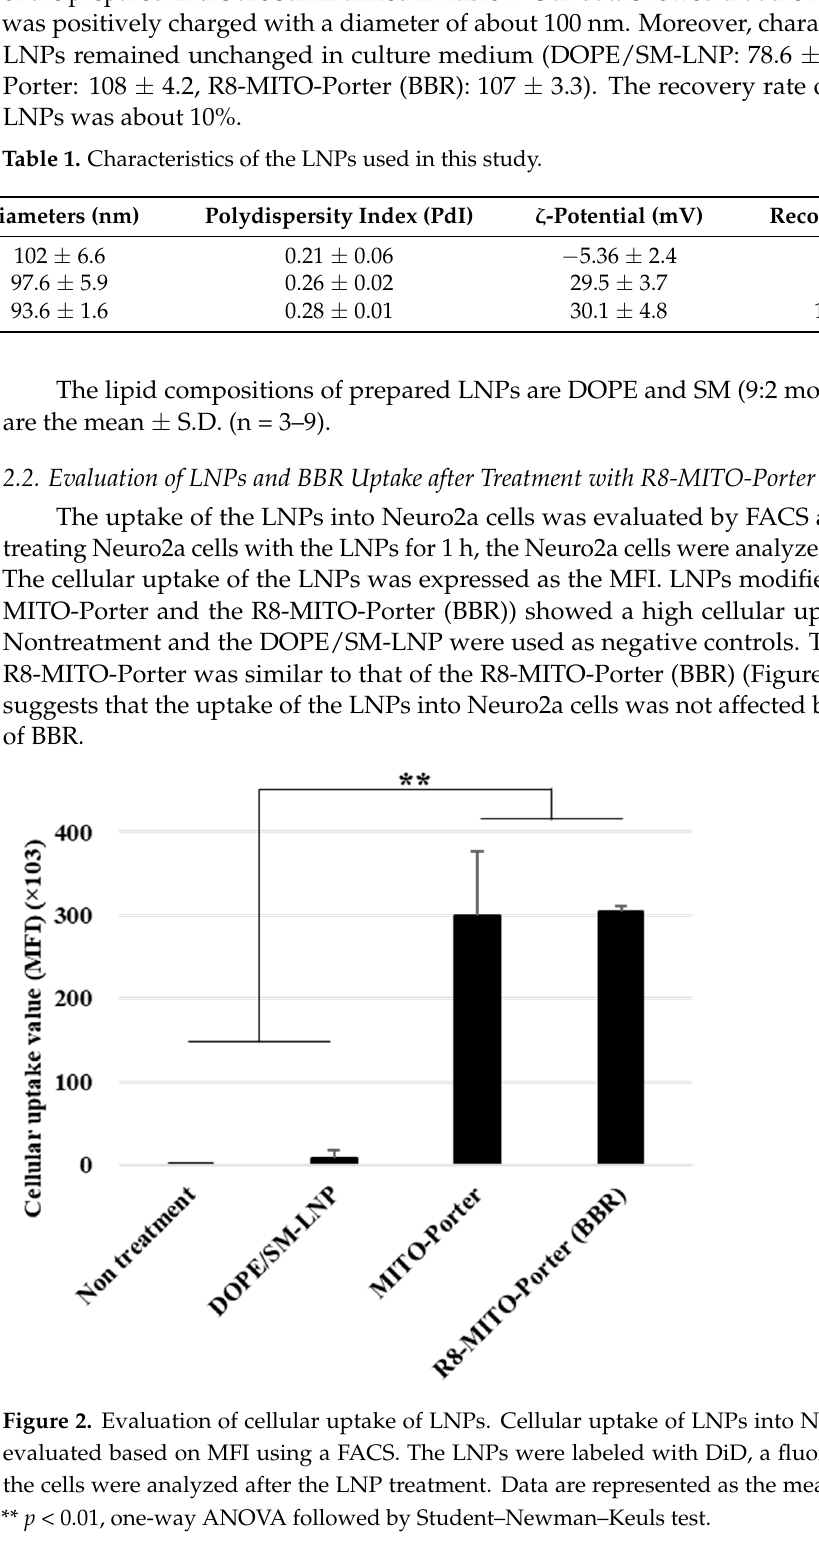
Table 1. Characteristics of the LNPs used in this study.